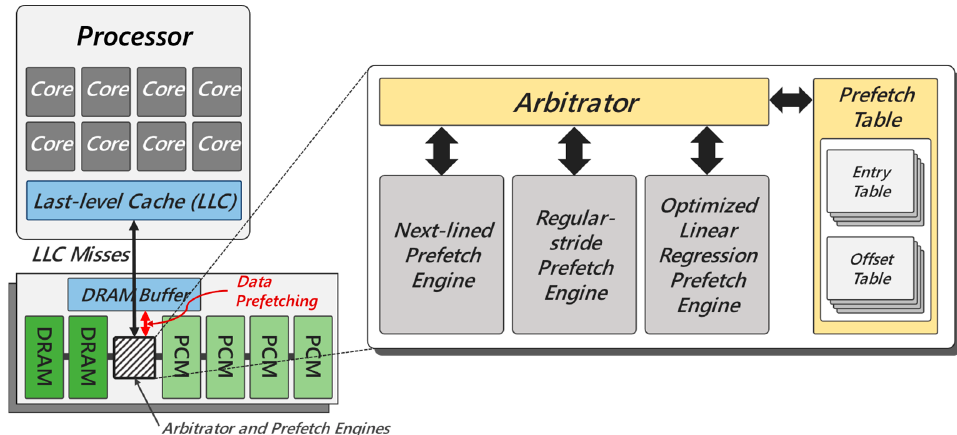
Figure 2. Overall